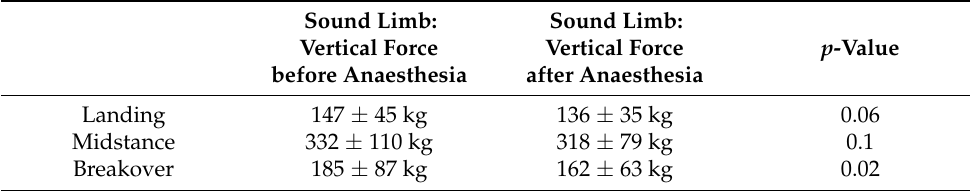
Table 7. Pairwise comparisons of the vertical force in kg on the sound limb before and after anaesthe- sia during landing, midstance, and